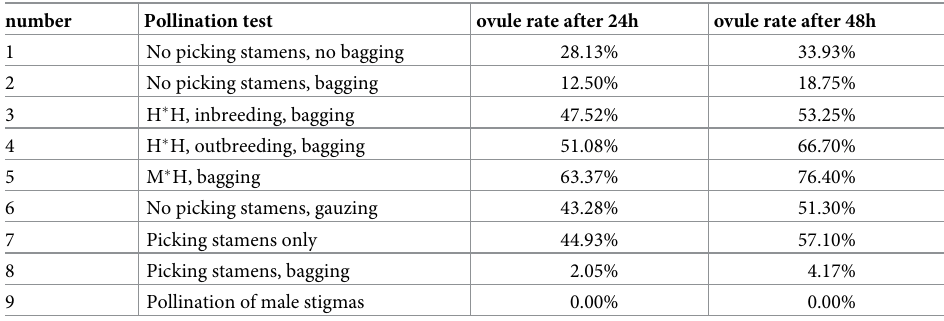
Table 7. Ovule fertilization rate 24 and 48 hours after artificial